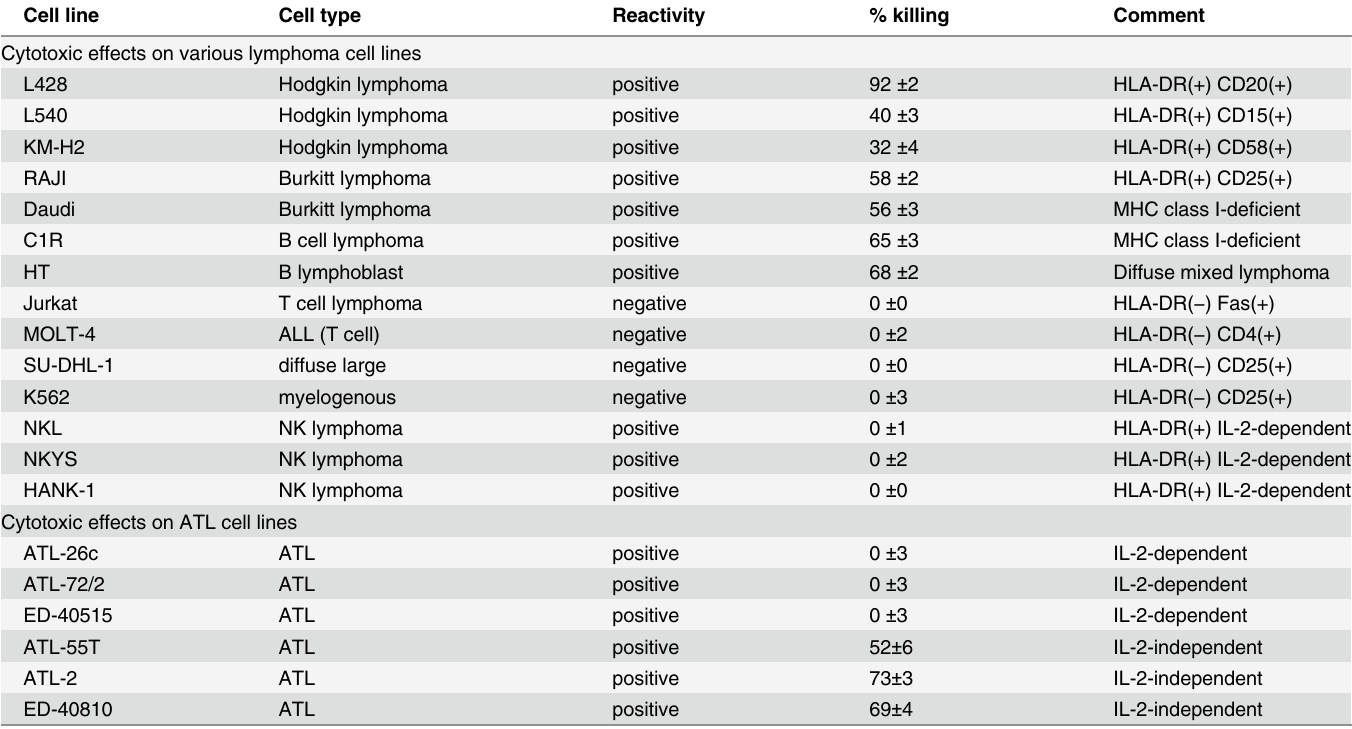
Table 1. Cytotoxic effects of mAb4713 on lymphoma/leukemia cell lines.